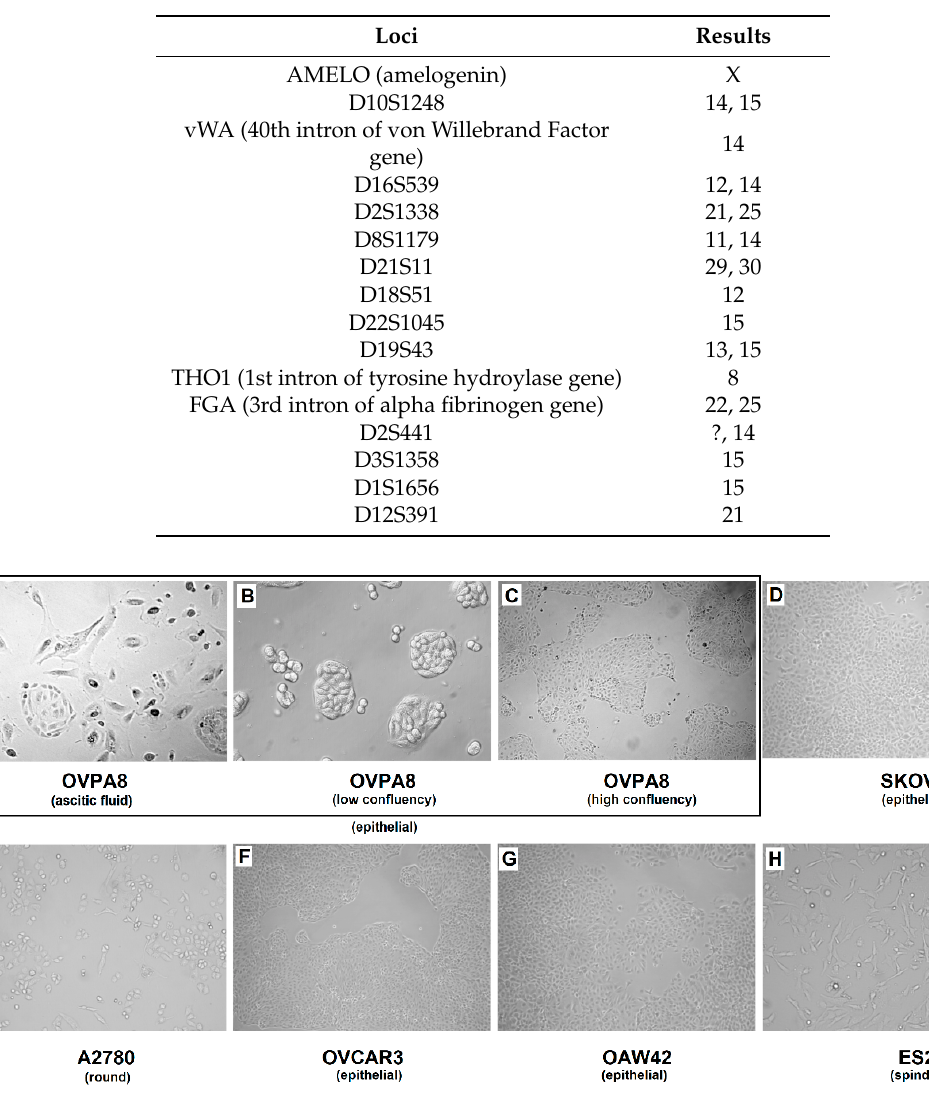
Table 1. Short tandem repeats (STR) profile of OVPA8 cell line established using an AmpFLSTR NGM PCR Amplification Kit (Applied Biosystems, Waltham, MA, USA). Question mark (?) was inserted there because the reading in this position was ambigous.